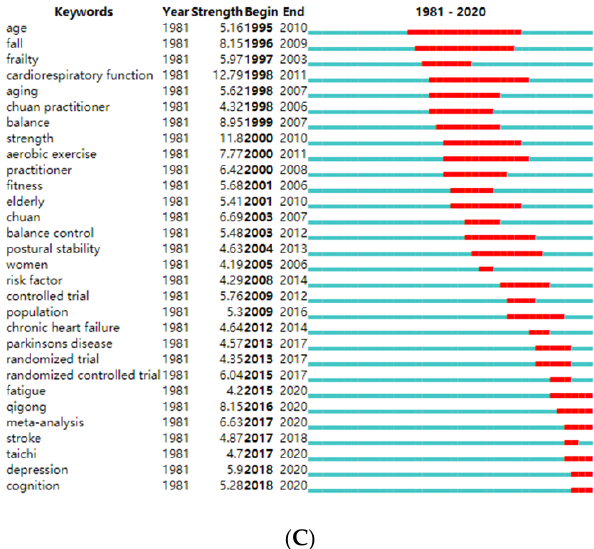
Figure 5. ( A ). Map of publication trends in the field of Tai Chi research; ( B ) Map of conspicuous